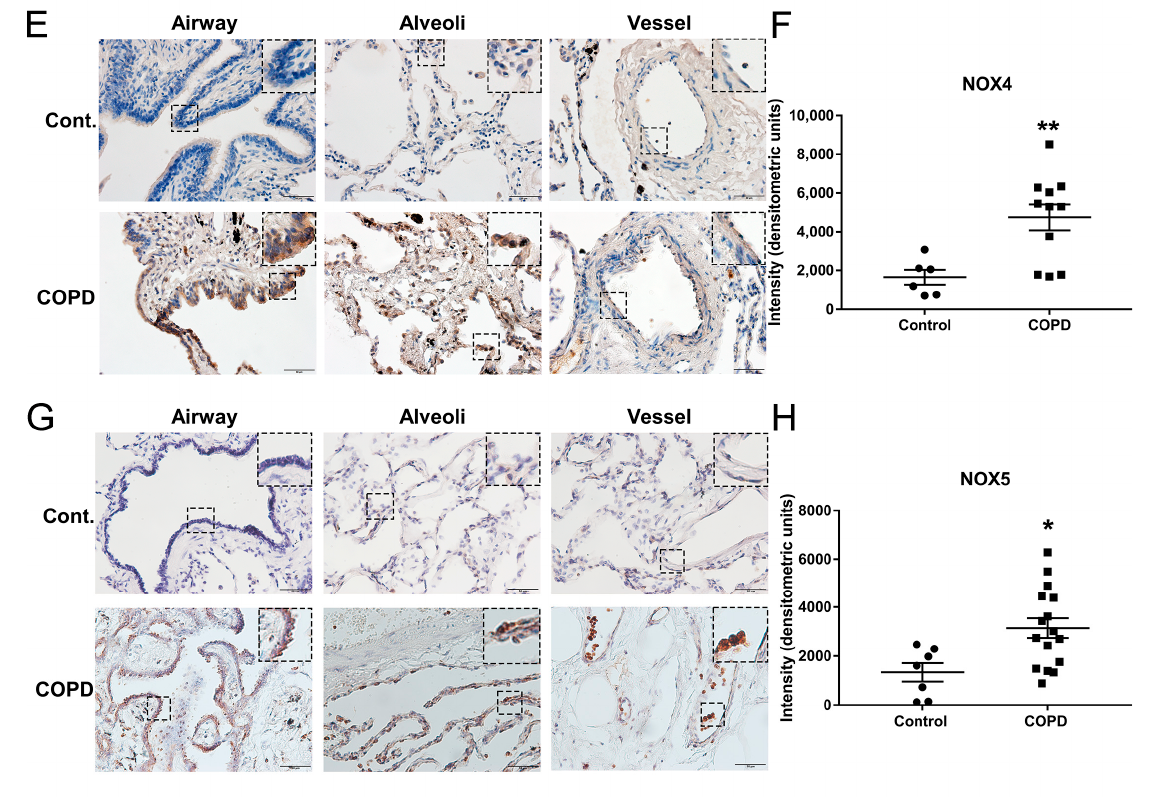
Figure 1. Upregulation of NOX1, NOX2, NOX4, and NOX5 in lung tissue sections of patients with end-stage COPD . Lung tissue sections of end-stage COPD patients and non-smoking donor controls were subjected to immunohistochemical staining using antibodies for NOX1, NOX2, NOX4, or NOX5. The representative images are shown in panels ( A , C , E , G ), while the grouped data are shown in panels ( B , D , F , H ). The data indicate that the protein expression levels of NOX1, NOX2, NOX4, and NOX5 were significantly upregulated in end-stage COPD patients compared to donor controls. All data are presented as Mean ± SEM, n = 6–18. Scale bar, 50 µ m. * p < 0.05; ** p < 0.01 vs. donor control